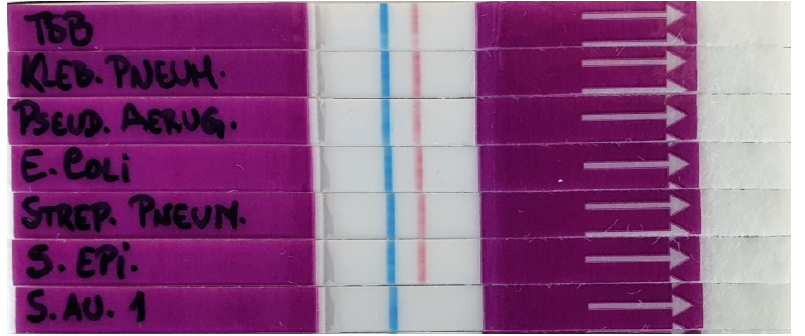
Figure 7. Specificity of the LF-TTprobe for S. aureus detection when tested with other common pathogens.